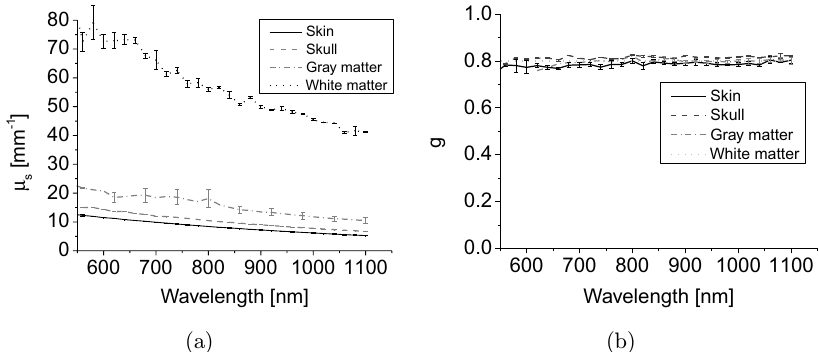
Fig. 4. Reconstructed optical properties: scattering coe±cient (a) decreases linearly with wavelength; anisotropy factor g and (b) remains constant ( g ¼ 0 : 8) for the whole spectral range. For the white matter phantom, g was calculated to be 0.8 based on additional measurements of thinner samples.